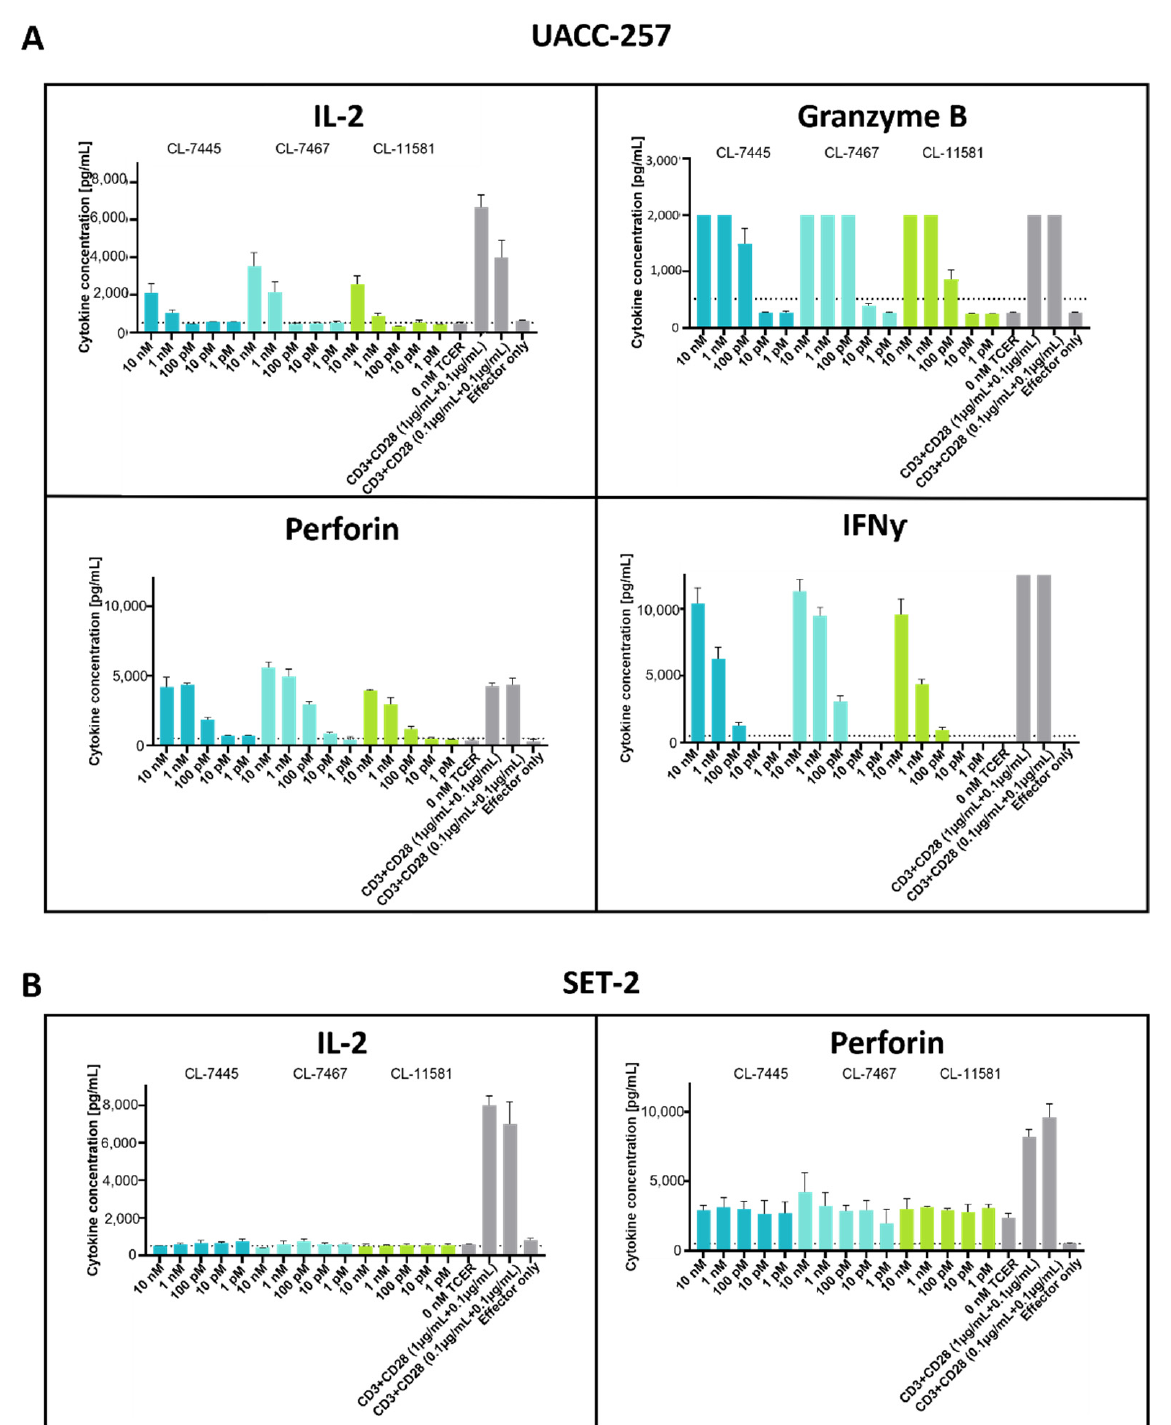
Figure 7. Assessment of TCER-mediated cytokine release from PBMC in response to tumor cells. PBMCs of a healthy human donor were co-cultured with tumor cells at an effector-to-target ratio of 10:1 and in presence of increasing TCER concentrations. CD3- and CD28-binding antibodies were used as positive control. Cytokine levels were determined using the MACSPlex cytotoxic T/NK cell kit. ( A ) UACC-257 (1100 cpc) was used as PRAME target pHLA-positive cell line and ( B ) SET-2 was used target negative control cell line. Each datapoint represents the mean of a triplicate with the respective SD.